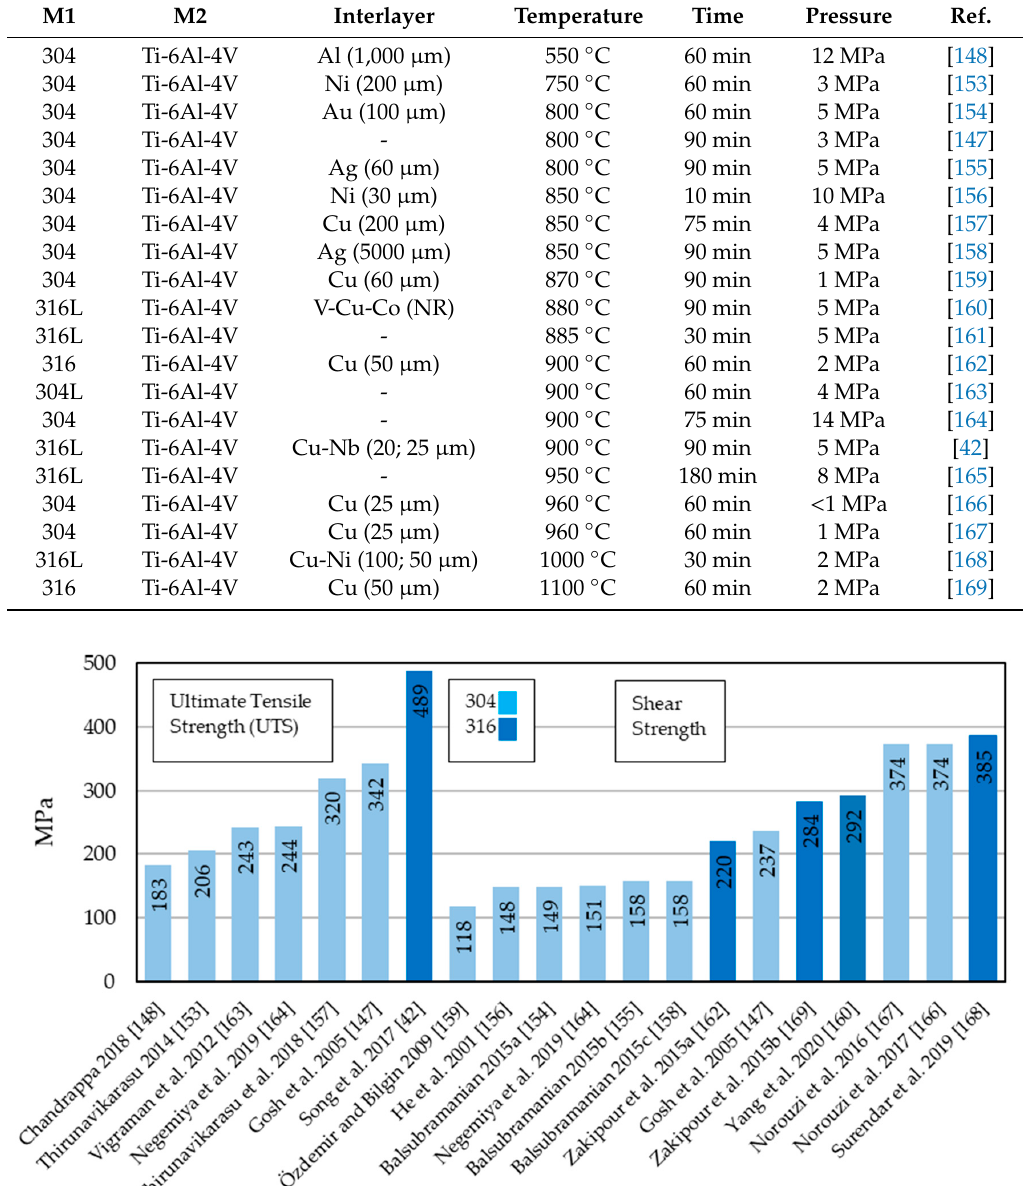
Table 6. Reported parameters for di ff usion bonding and TLP bonding of 304 to Ti-6Al-4V.